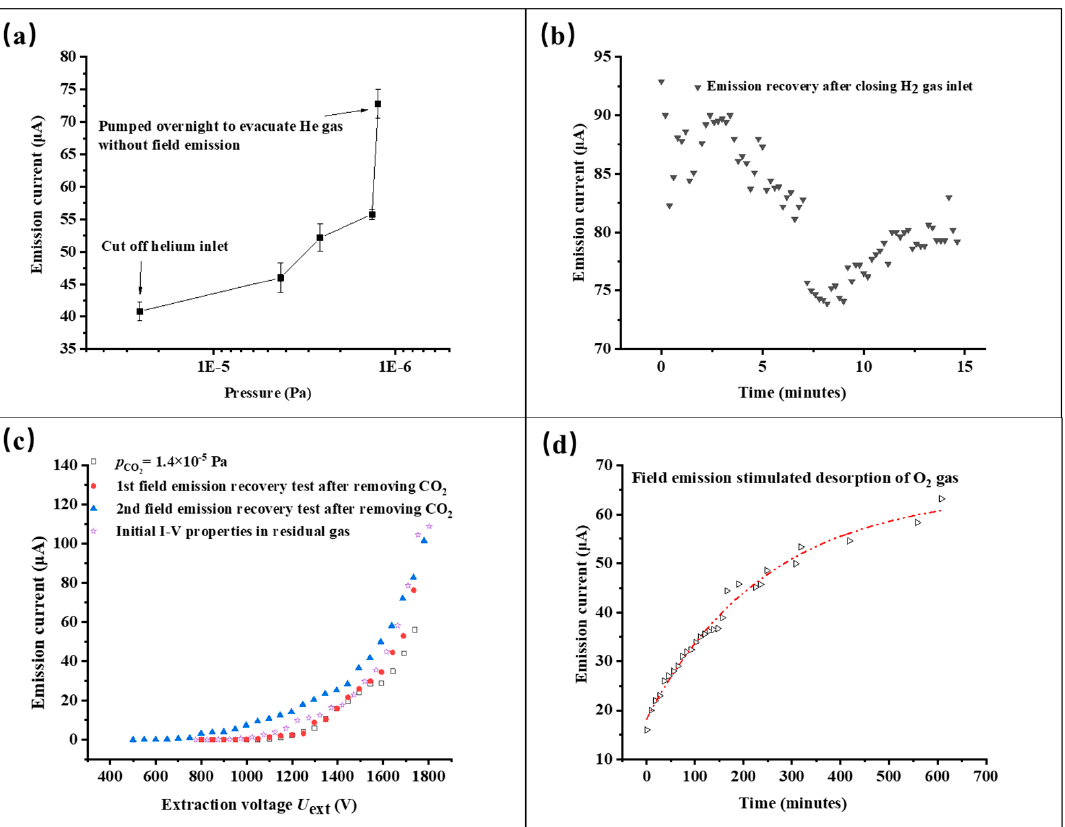
Figure 6. Reversibility of the electron field emission of CNT emitters after removing different operation gases, He ( a ), H 2 ( b ), CO 2 ( c ) and O 2 ( d ), from the CNT-LEIS.